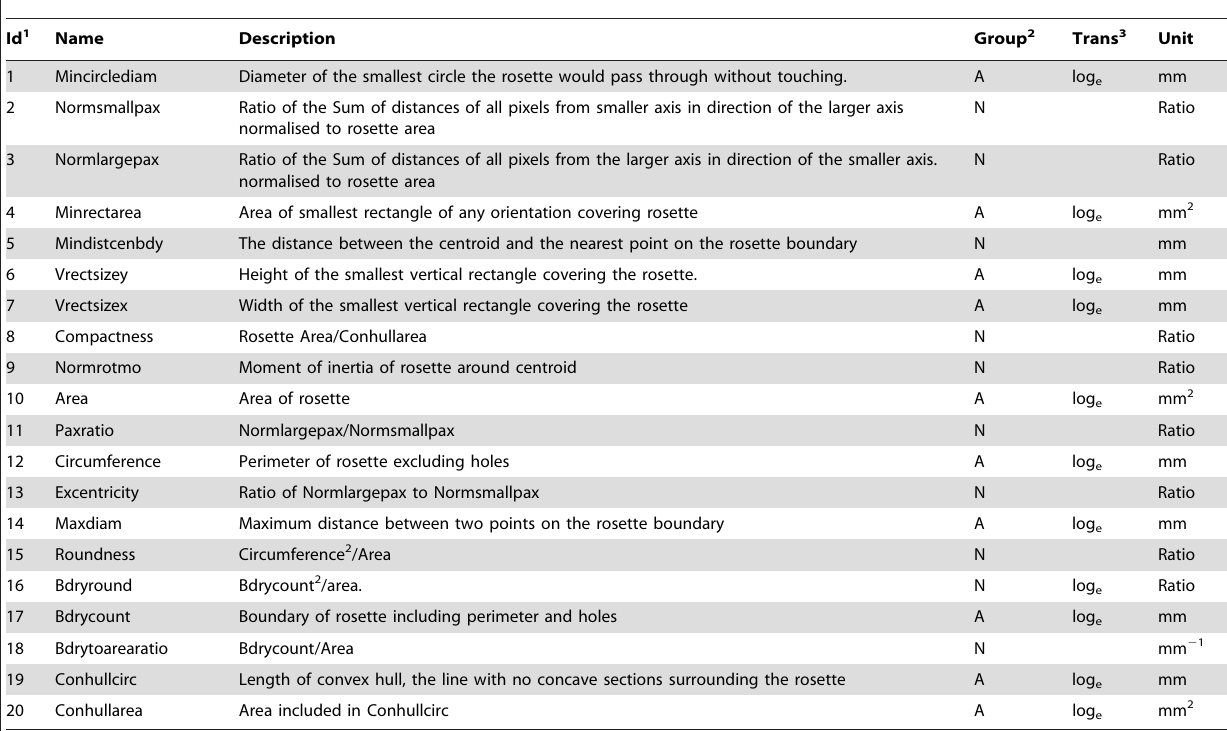
Table 1. Shape descriptors extracted from segmented Arabidopsis